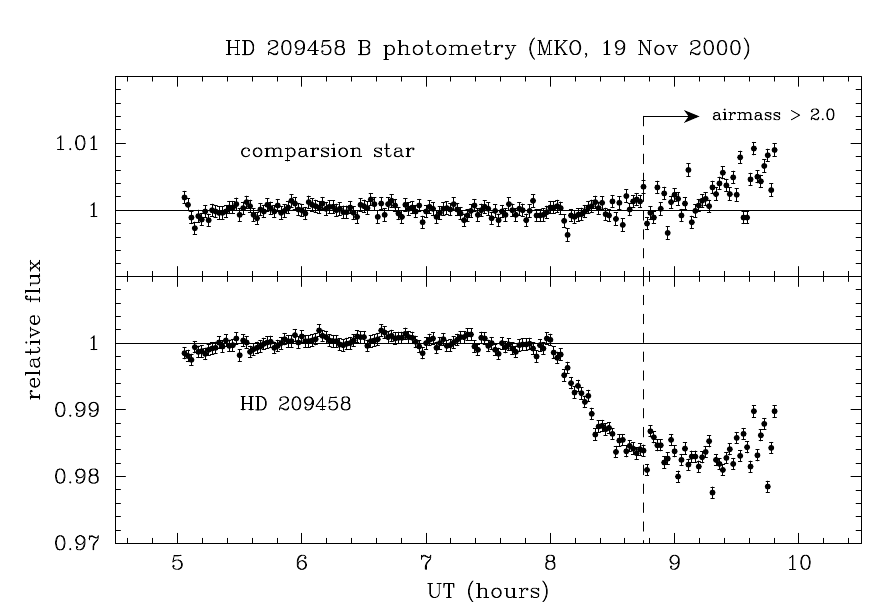
Fig. 9. Relative flux values for the target and comparion stars deduced from the differential magnitudes obtained from Fig. 8.